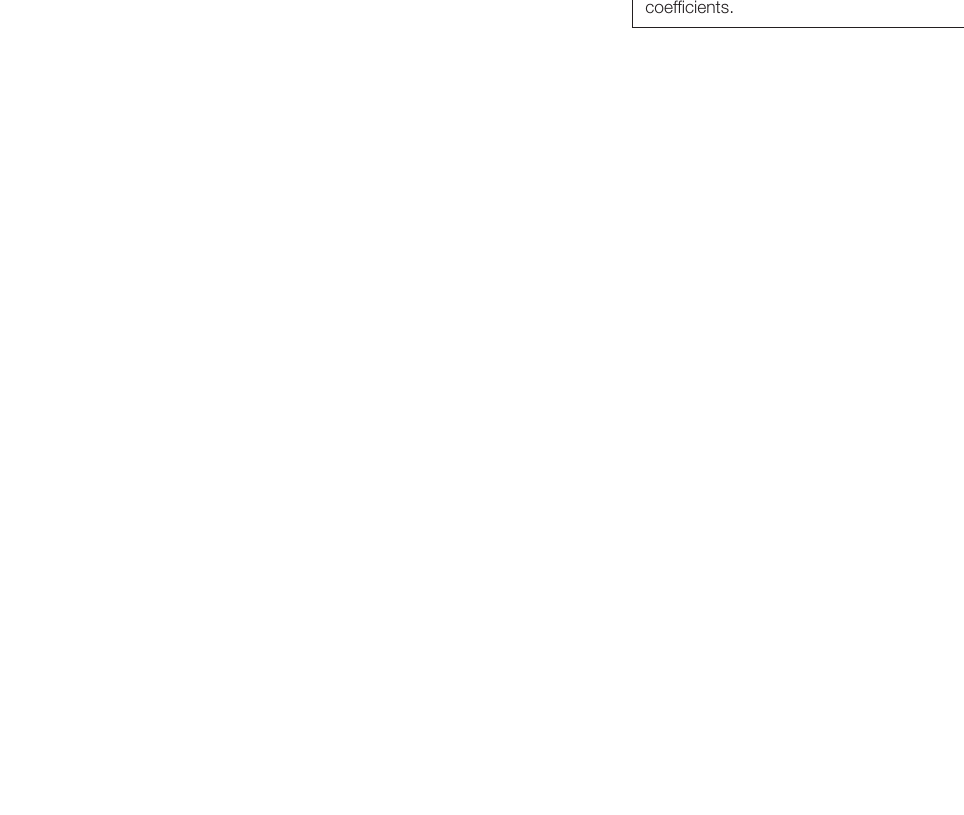
SUPPLEMENTARY FIGURE 7 | Clustering patterns of the seagrass fungal microbiome. Hierarchical cluster analysis (CLUSTER) of fungal microbiomes, based on a lower triangular resemblance calculated with the S17 Bray-Curtis similarity measure from relative abundances of OTUs (high values down-weighted with square root). Samples are colored by microenvironment (RR, roots and rhizomes; Sed, sediment, SW, seawater), with different shapes for sites (PB, Palm Beach; RB, Rose Bay; N, Narrabeen Lagoon; LM, Lake Macquarie). Group average linkage was used to calculate distances between clusters and generate a dendogram and a cophenetic distance matrix (unsupervised learning method). The cophenetic correlation index (CCI) is provided in the upper right corner of the dendogram, and it was used to assess the faithfulness of the dendogram by computing cophenetic correlation